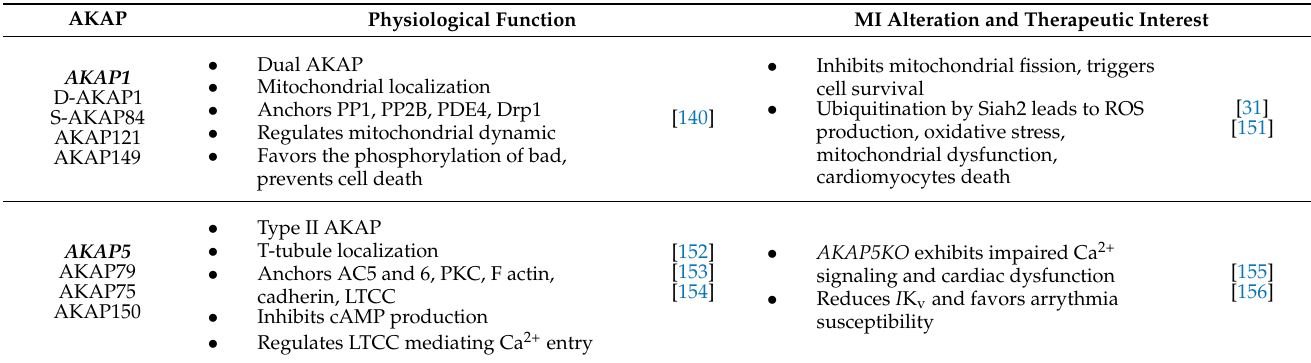
Table 2. Role of cardiac AKAPs in physiological and in myocardial infarction. AKAP: A-kinase anchoring protein; MI: myocardial infarction; PP1/2B/2A: Protein Phosphatase 1/2B/2A; PDE: phosphodiesterase; Drp1: Dynamin Related Protein 1; AC5/6: adenylyl cyclase 5/6; PKC: Protein Kinase C; LTCC: L Type Calcium channel; cAMP: cyclic Adenosine Monophosphate; Epac 1: Exchange Protein Activated by cAMP; RyR: Ryanodine Receptor; NCX: Na/Ca exchange; HIF1 α : Hypoxia Induce Factor 1 α MEF2: Myocyte Enhancer Factor 2; NHERF: Na + /H + Exchanger Regulatory factor;